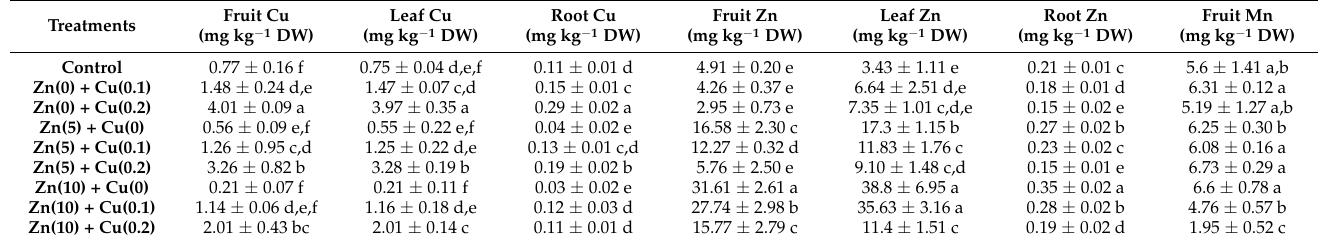
Table 4. Means related to the interaction effects of added Cu and Zn to a basal nutritional solution on Cu, Zn, and Mn content of C. pepo